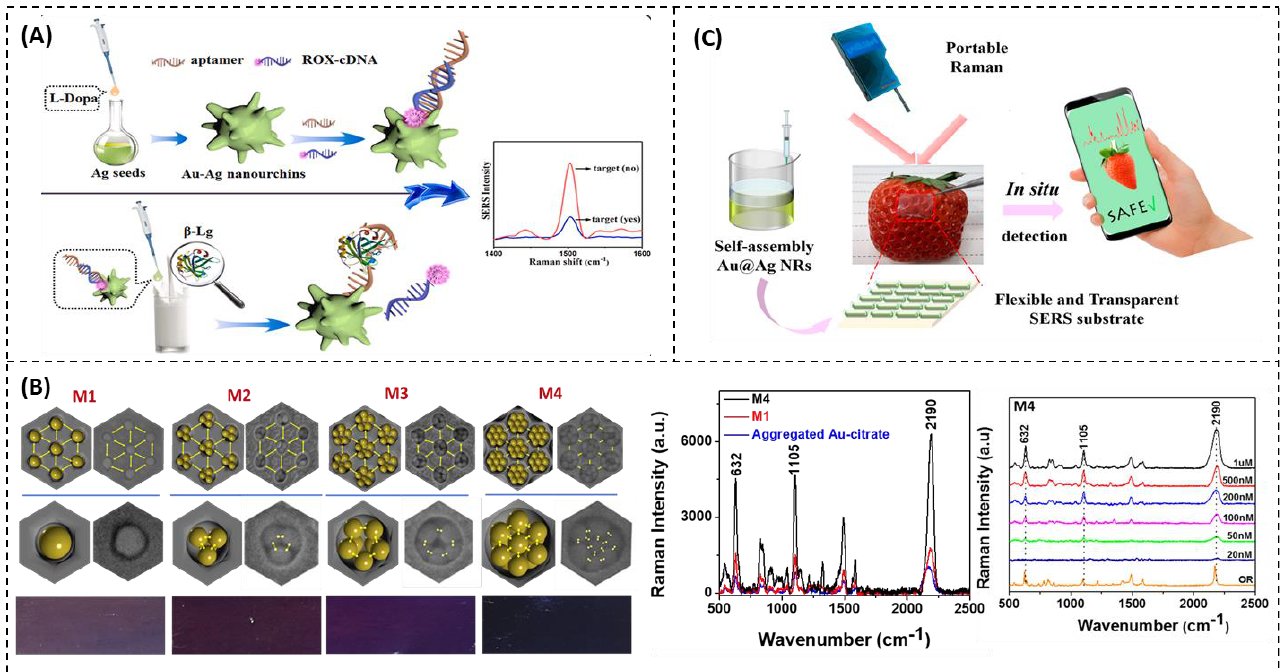
Figure 4. The application of SERS for food monitoring. ( A ) SERS-based aptasensor for β -lactoglobulin (β -Lg) determination using Au-Ag nanourchins as active substrates. Reprinted with permission [148], copyright 2022, Elsevier. ( B ) Controlling numbers of gold nanoparticles in the highly ordered AAO nanopore as SERS substrates with the limit of detection of 20 nM. Reprinted with permission [179], copyright 2019, American Chemical Society. ( C ) In situ detection of pesticide residue by flexible and transparent Au@Ag nanorid array. Reprinted with permission [177], copyright 2022, MDPI.